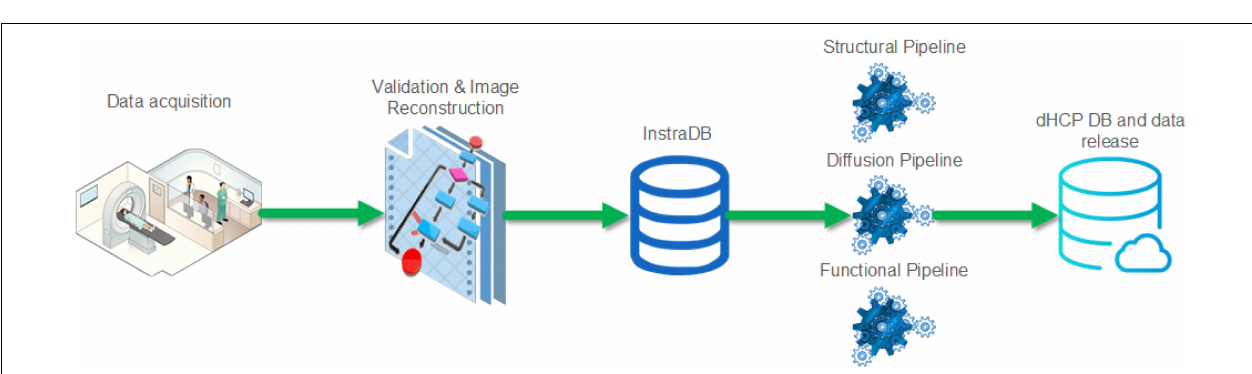
FIGURE 2 | Schematic of the Developing Human Connectome Project imaging data flow from acquisition to data